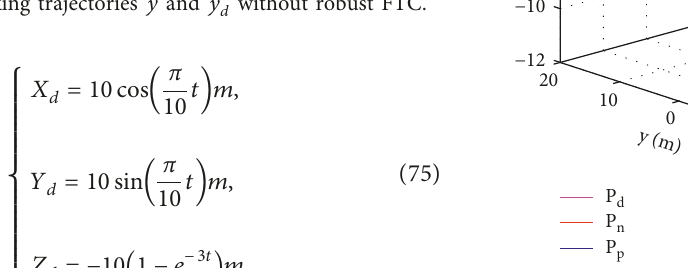
d without robust FTC.